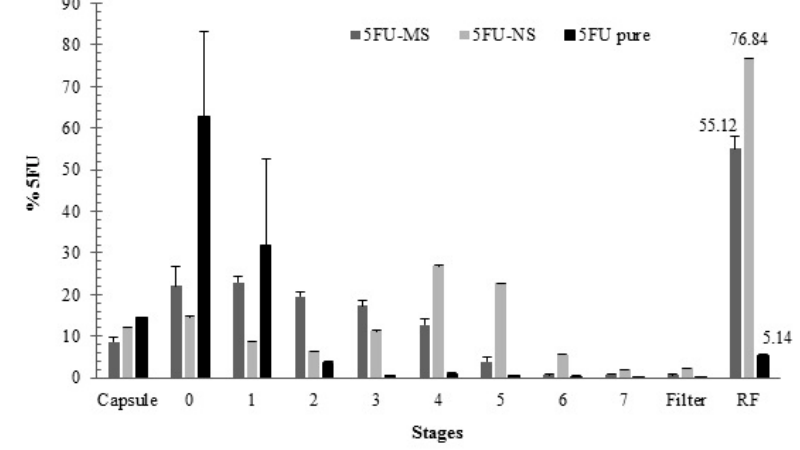
Figure 4. Deposition Performance (% 5FU) by ACI: 5FU-NS and 5FU-MS formulations, and drug 5FU pure (mean ± SD; n = 3).